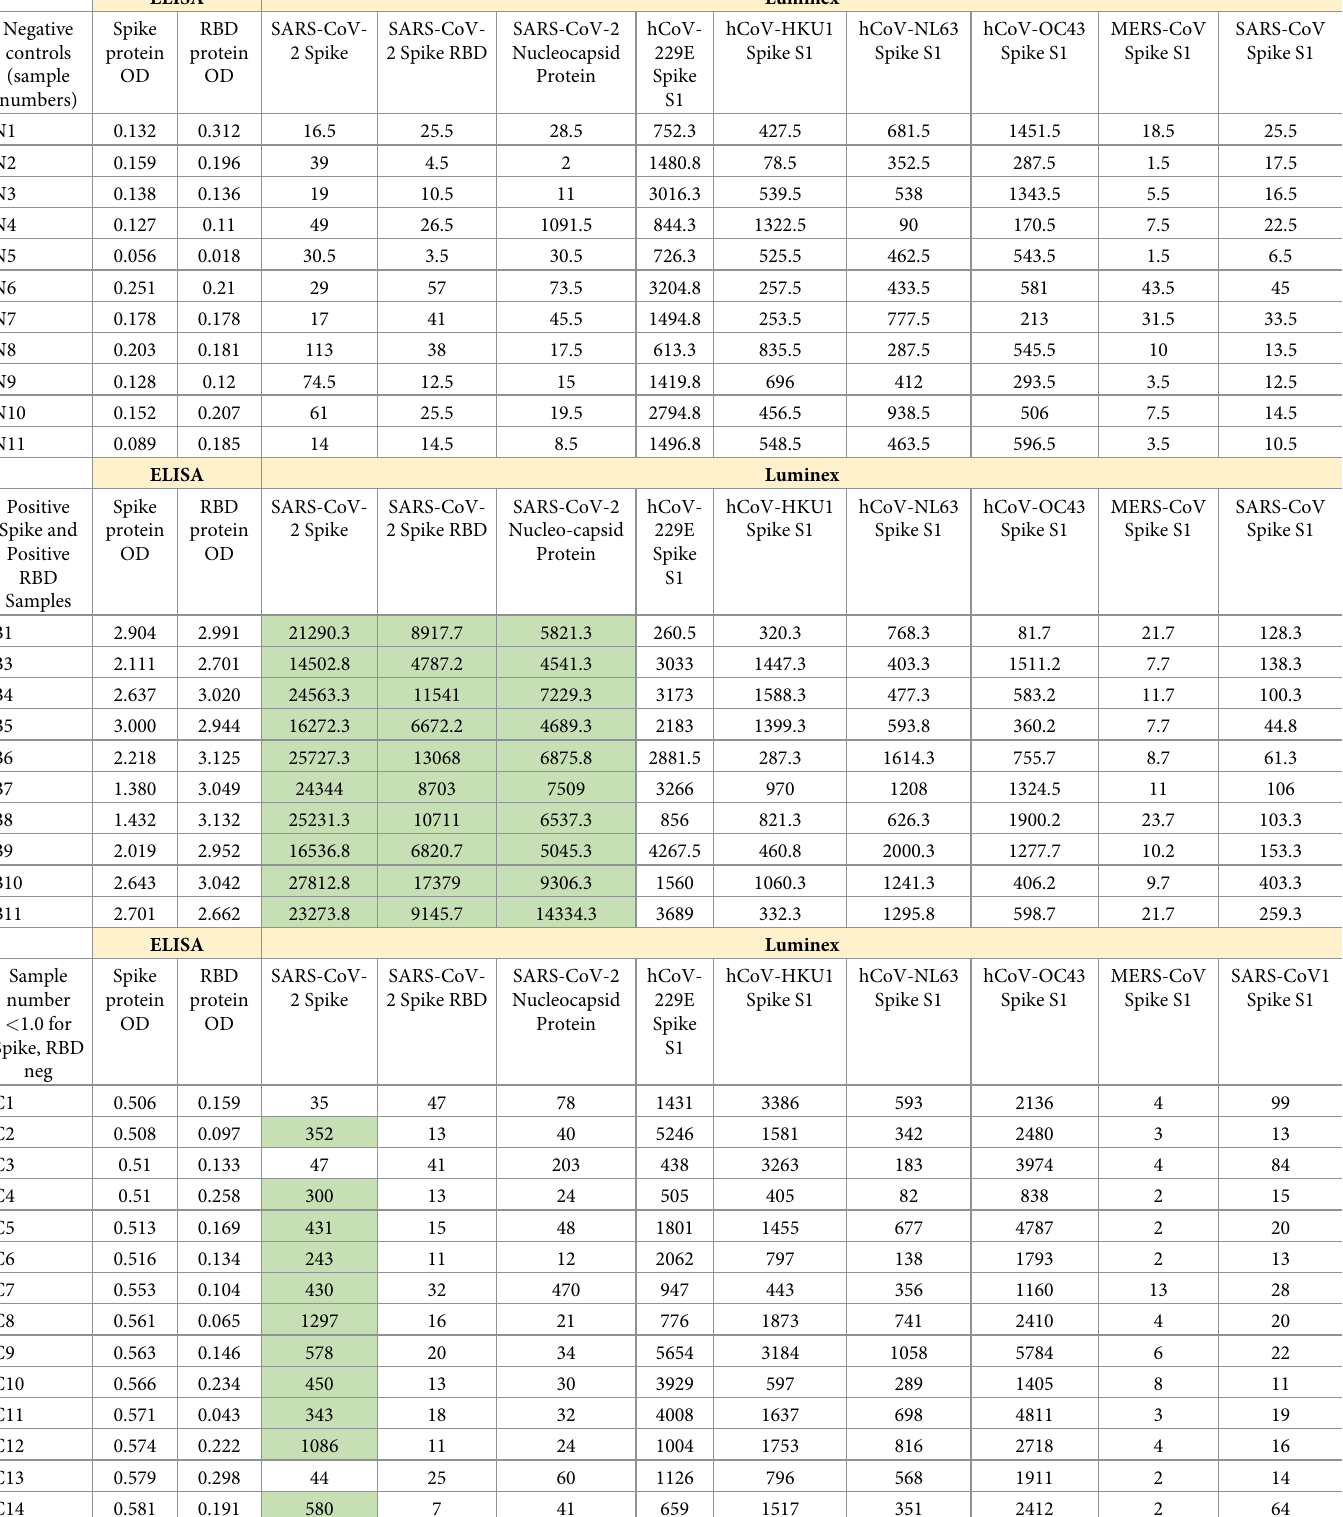
Table 2. Comparison of S protein ELISA versus Luminex immunodetection of S, RBD, N protein and status of the 4 hCoVs and MERS and SARS-CoV-1. ELISA